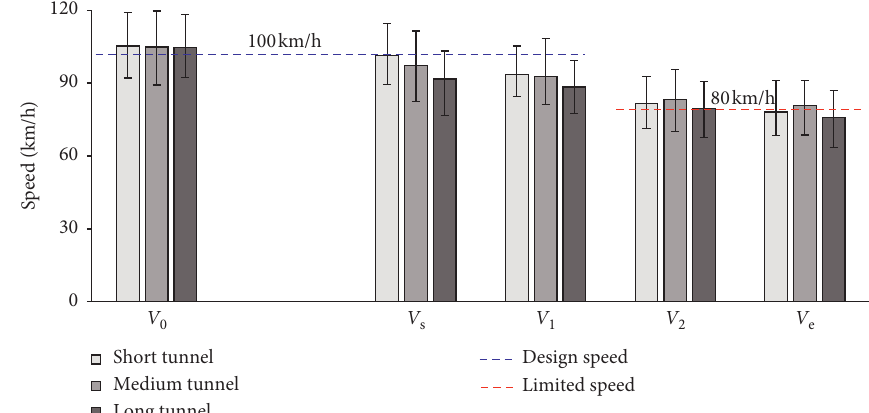
Figure 4: Drivers’ speeds at tunnel